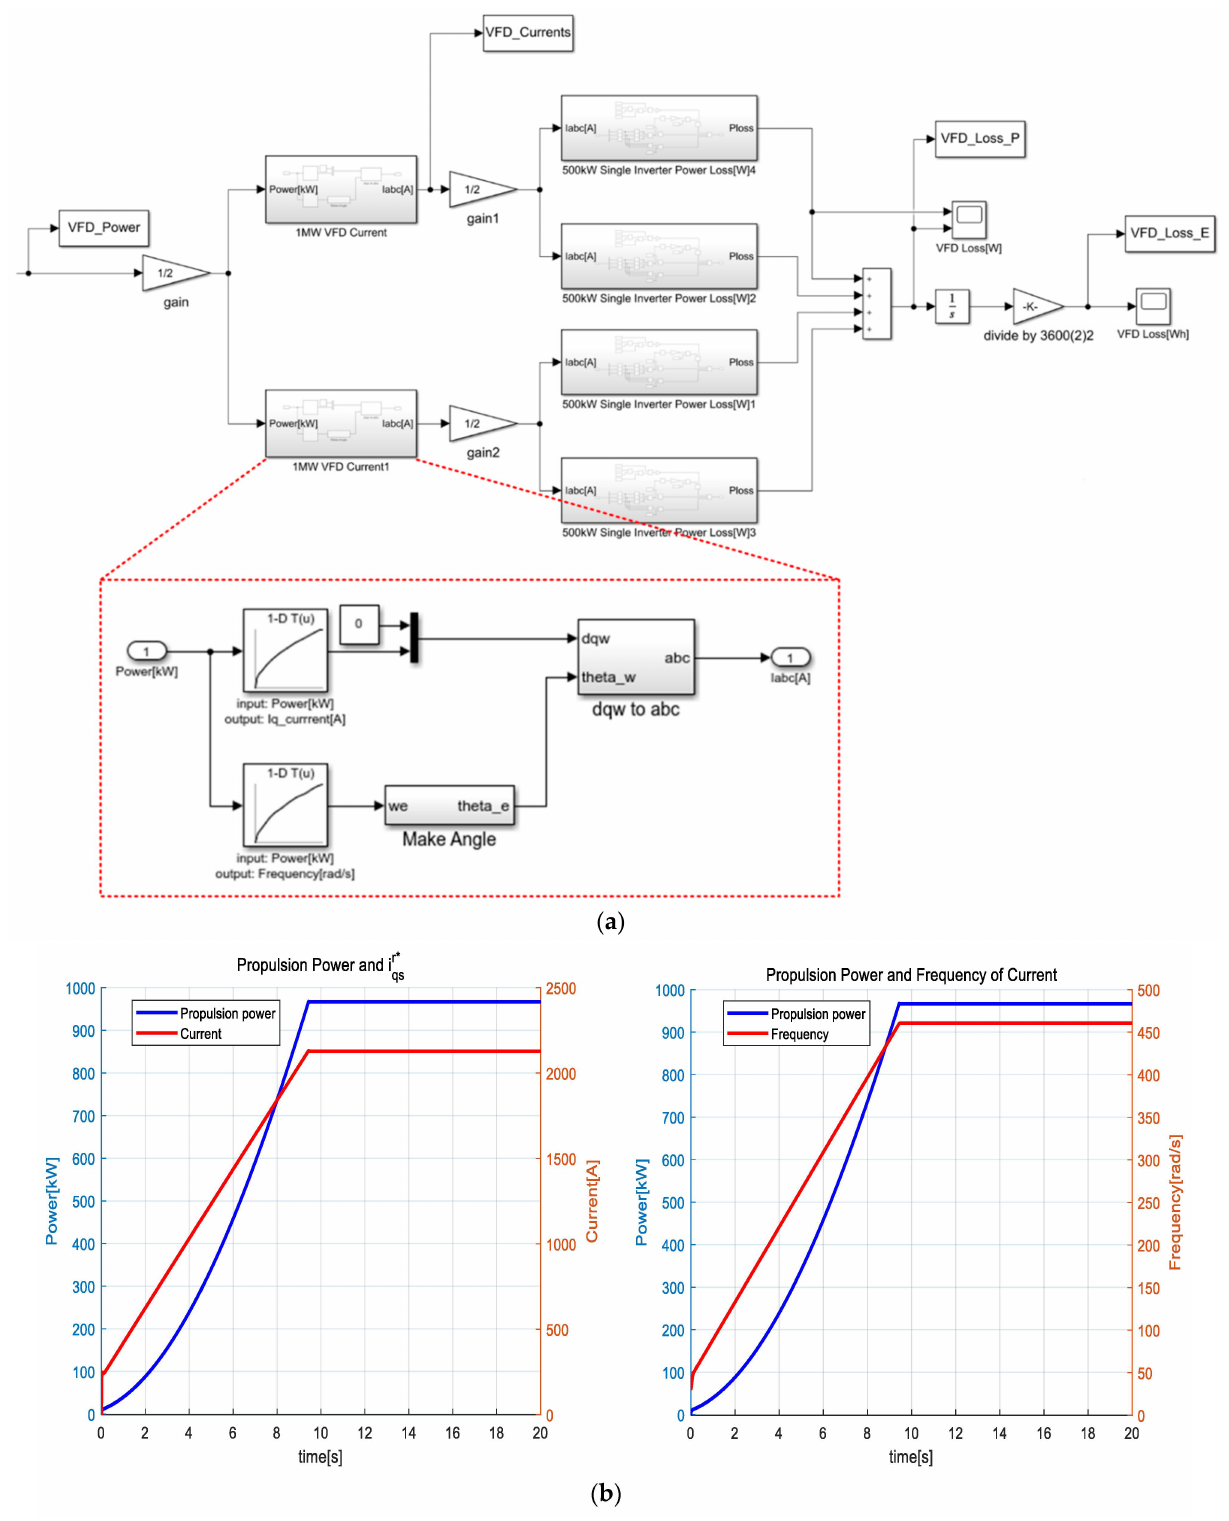
Figure 21. 1 MW VFD inverter power loss model and loss look up table ( a ) and current and frequency ( b ) according to propulsion